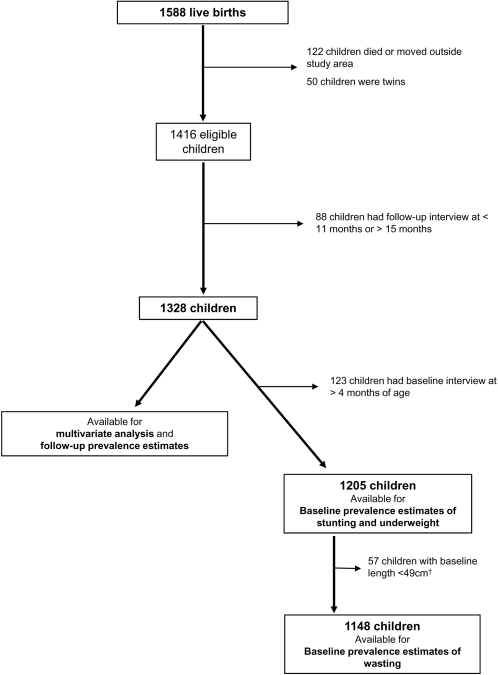
Study design.
Footnote:
†The NCHS reference does not allow for calculation of weight-for-length for children <49 cm